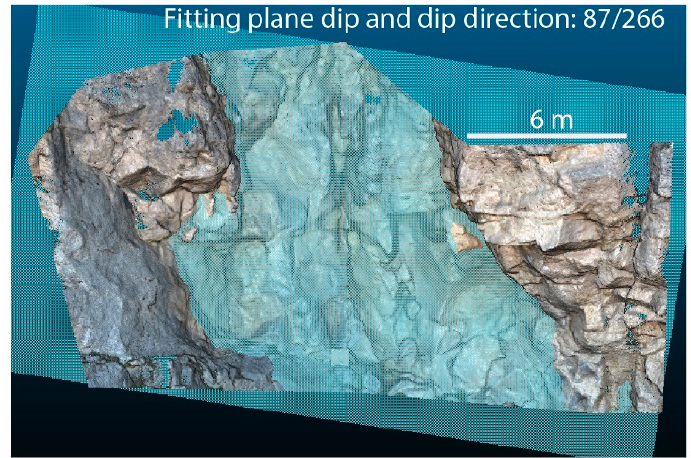
Figure 16. Extraction of slope orientation in CloudCompare.